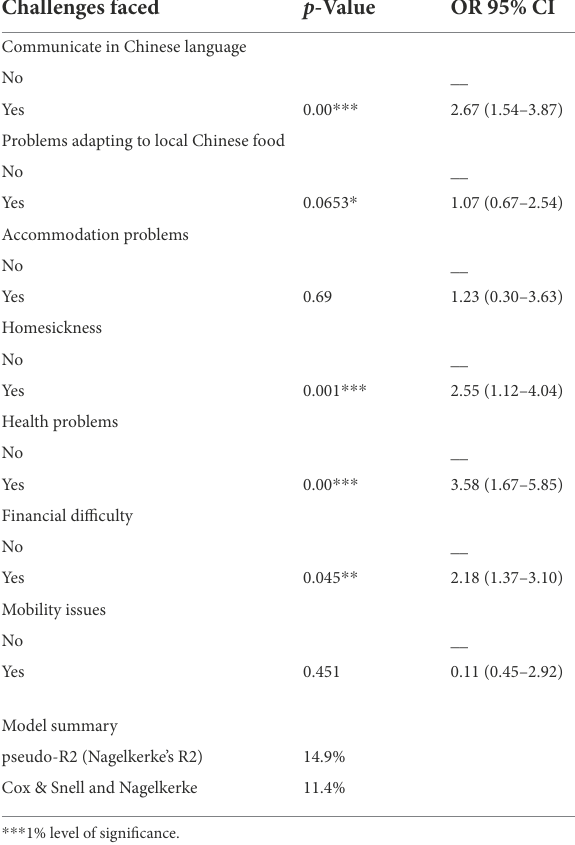
TABLE 2 Challenges and depressive symptoms (multivariate binary logistic regression results). Challenges